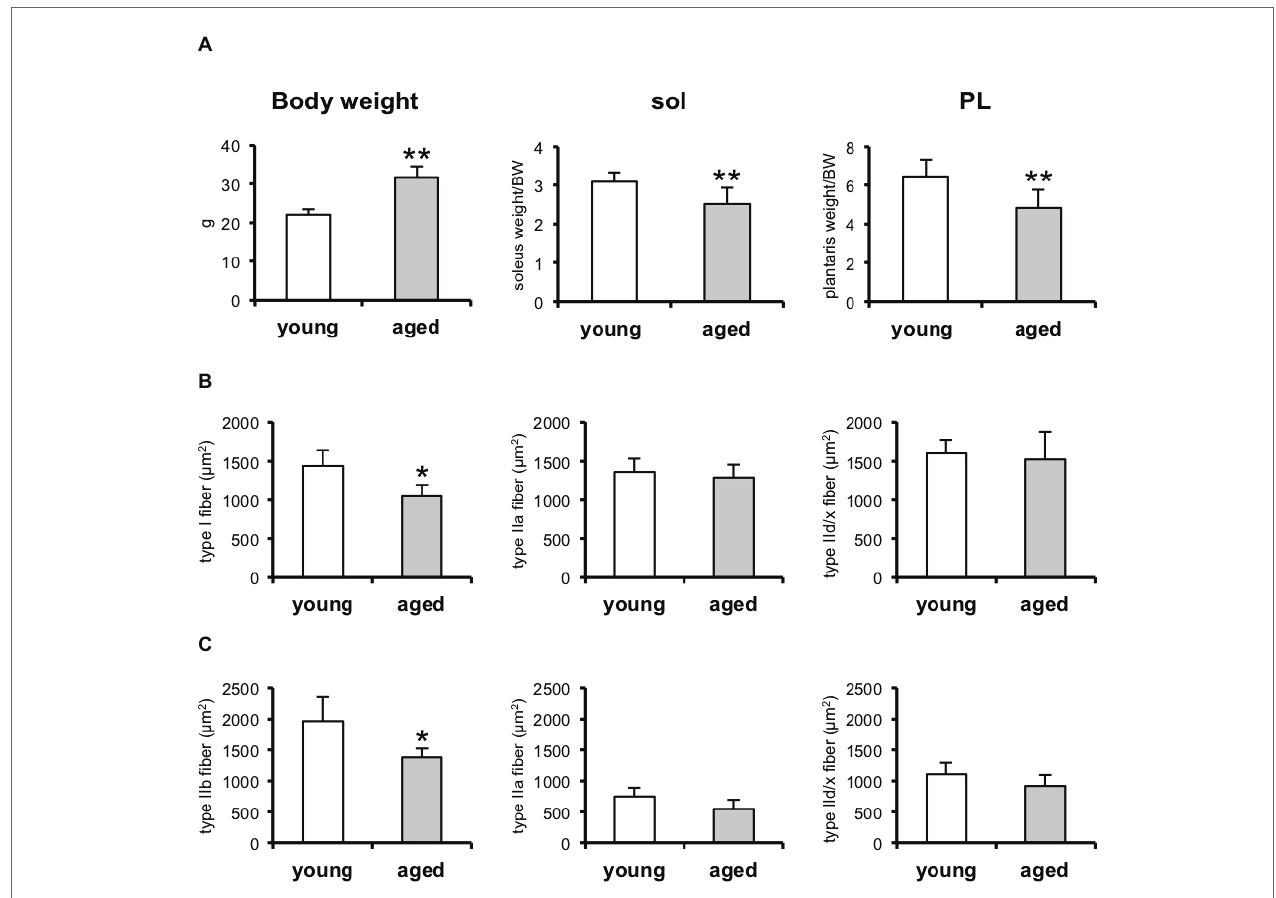
FIGURE 1 | Skeletal muscle weights and cross-sectional areas (CSAs) of skeletal muscles in young and aged mice. (A) Bodyweight, soleus (sol) and plantaris (PL) muscle weights relative to bodyweight (BW). Young, n = 6; aged, n = 6. (B) CSA of type I, IIa, and IId/x in soleus muscles. Young, n = 6; aged, n = 5. (C) CSA of type IIb, IIa, and IId/x in plantaris muscles. Young, n = 6; aged, n = 5. Data are presented as means ± SD. ** p < 0.01, * p < 0.05 vs. the young